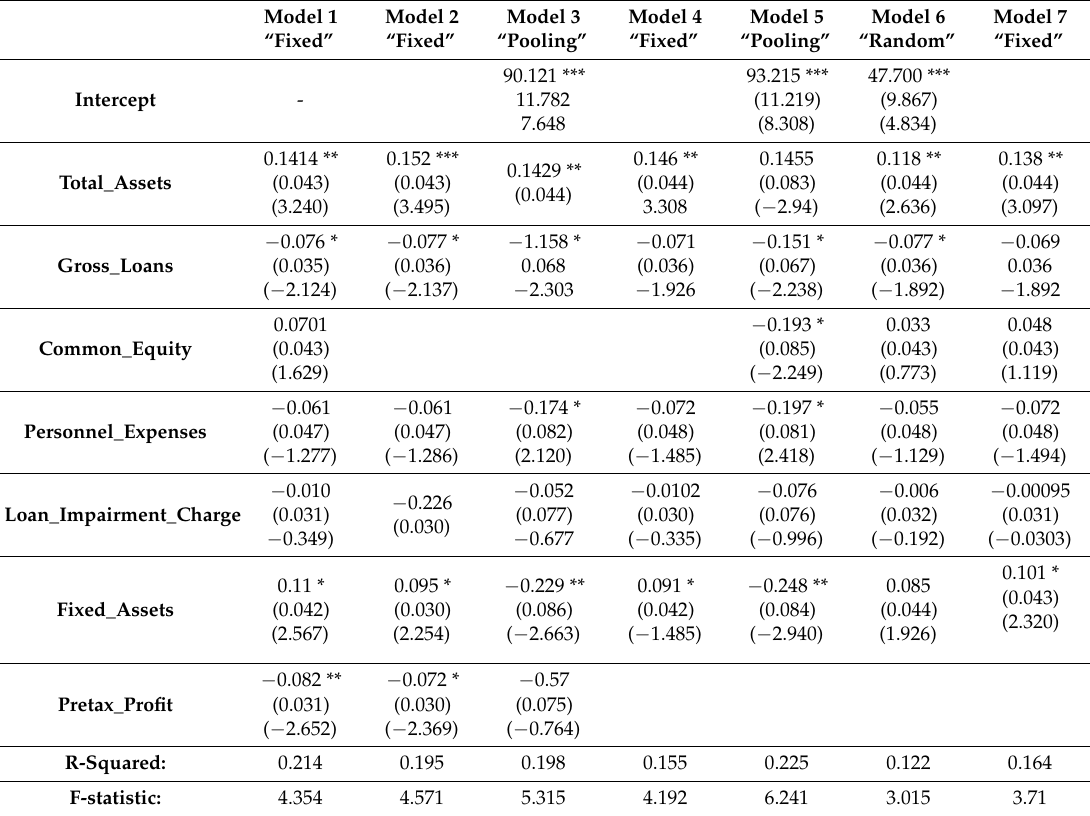
Table 8. Results of panel regression model for the Baltic Countries (dependent variable